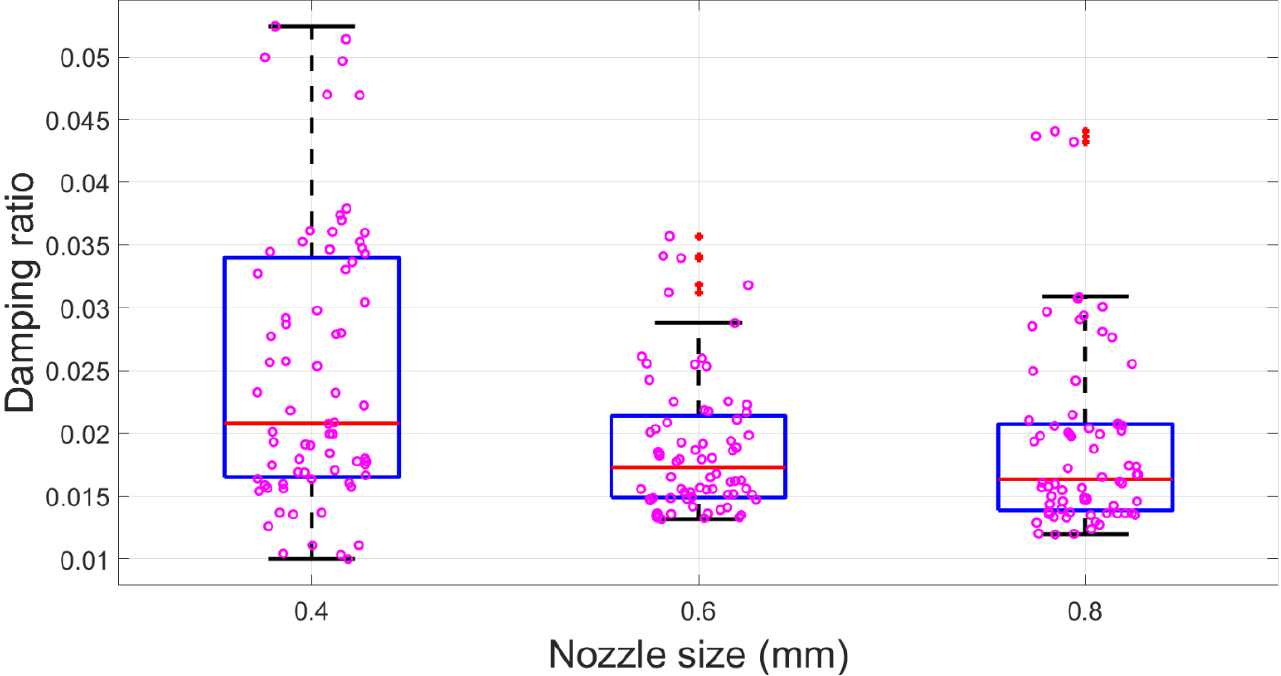
Figure 7. Damping factor box plots for nozzle size. Red dots are outliers. Violet circles are raw data. Table 3. Correlation analysis results for nozzle size and infill density.